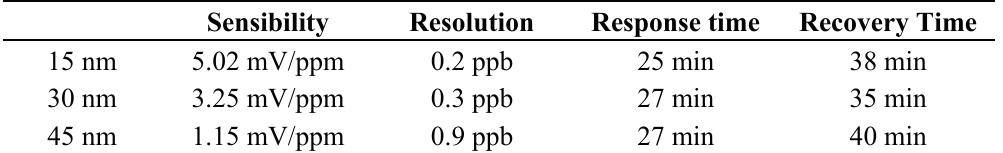
Figure 7. Repeatability performance for the 15 nm thickness NO 2 optical fiber sensor. Table 1. Characterization of the sensors depending on their